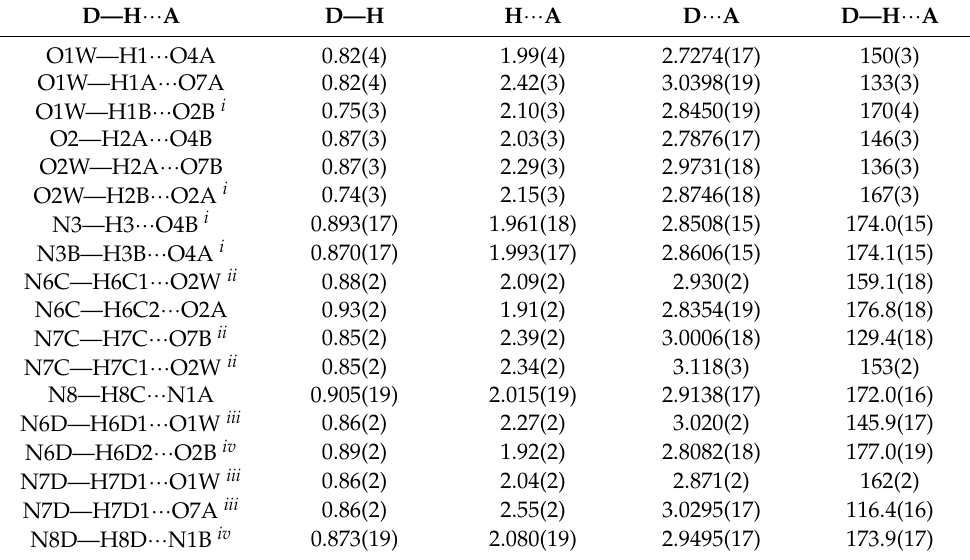
Figure 23. A detail of the hydrogen bonded ribbons in (XIX) . 5NU dimer is highlighted in solid colors (yellow and red). Table 9. Hydrogen bond geometry of phenylguanidinium 5-nitrouracilate monohydrate ( Å, ◦